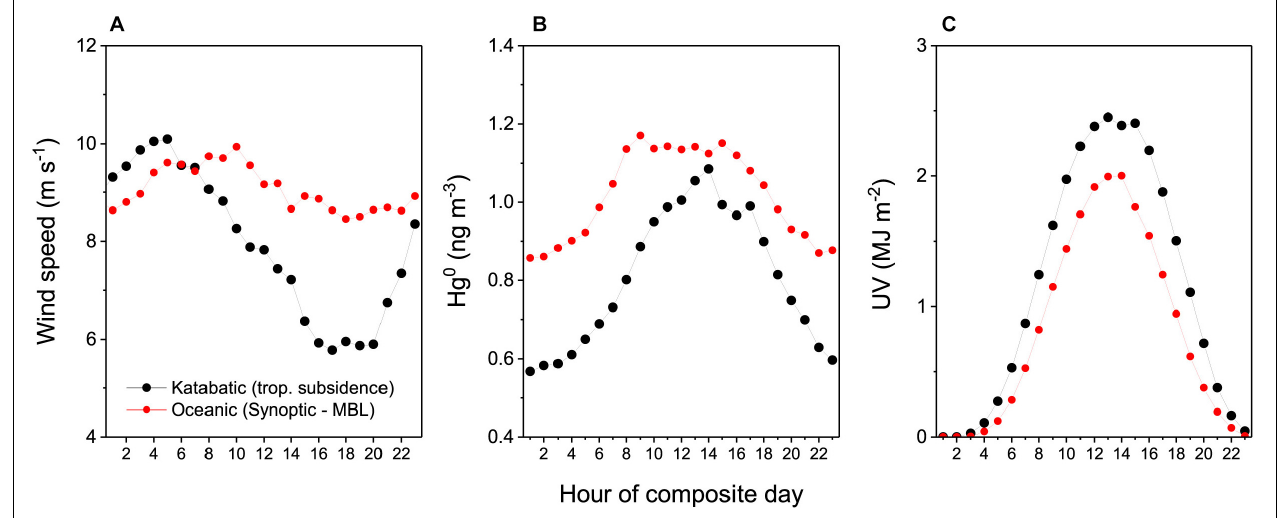
FIGURE 10 | Diurnal composite (A) wind speed, (B) gaseous elemental mercury, and (C) ultraviolet radiation, at DDU (January-2012 to May-2015).